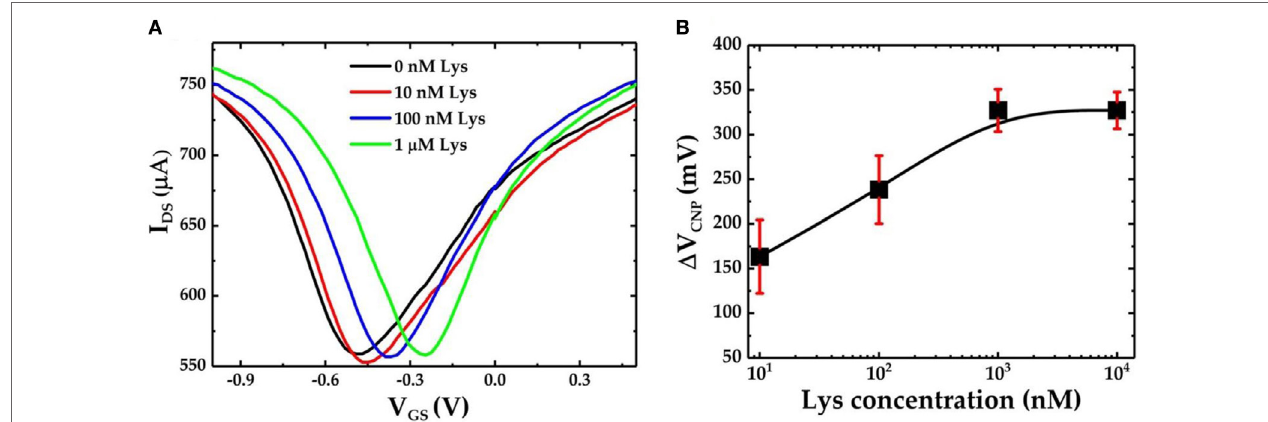
FigUre 4 | (a) I DS – V GS characteristics of the graphene field-effect transistor (GFET)-based biosensor device when it is exposed to varying concentrations of lysozyme protein and (B) the calibration curve for the GFET-based biosensor showing Δ V CNP as a function of different concentrations of lysozyme. The sample set is n = 3, and the error bar represents 1 SE.